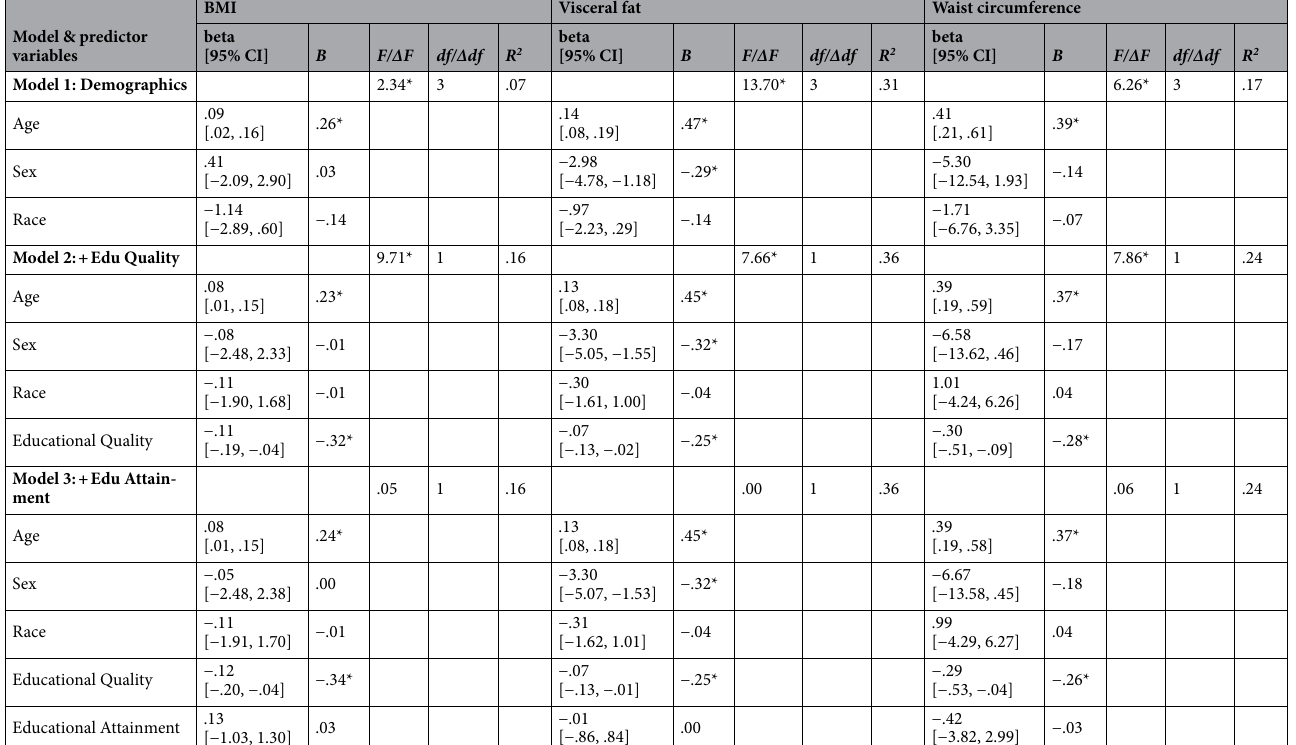
Table 3. Results of regression models predicting BMI, visceral fat and central adiposity in the ABSoRD sample. * p <